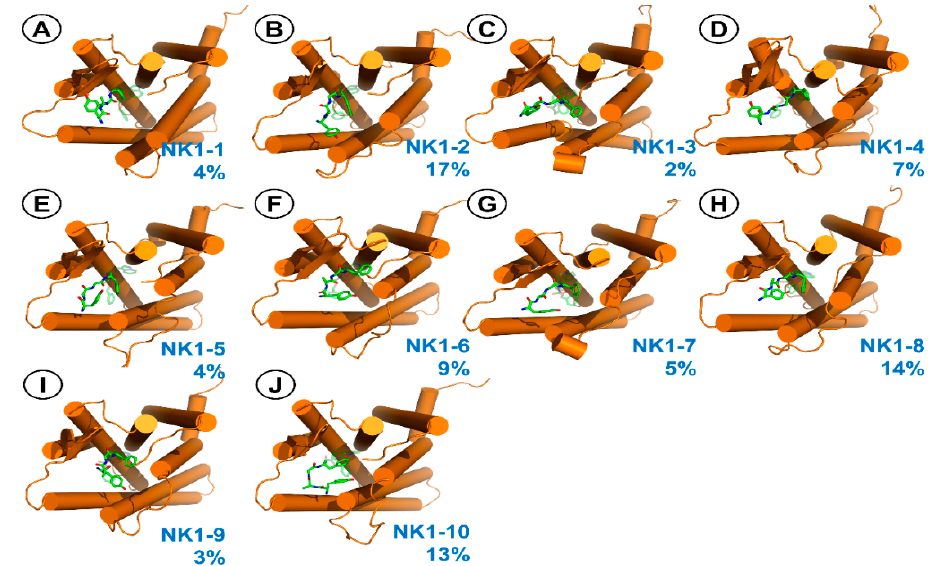
Figure 9. Representative structures for the clusters from MD simulations of AA3266 in the NK1R binding site. Focus on the Tyr- D -Ala-Gly-Phe- fragment. ( A ) NK1-1 cluster, ( B ) NK1-2 cluster, ( C ) NK1-3 cluster, ( D ) NK1-4 cluster, ( E ) NK1-5 cluster, ( F ) NK1-6 cluster, ( G ) NK1-7 cluster, ( H ) NK1-8 cluster, ( I ) NK1-9 cluster, ( J ) NK1-10 cluster. Receptor is represented as orange cylinders (transmembrane helices, TM). The ligand is shown as green sticks. The blue number is the cluster population. Table 6. Description of representative structures for clusters related to Tyr- D -Ala-Gly-Phe- fragment position in NK1R.